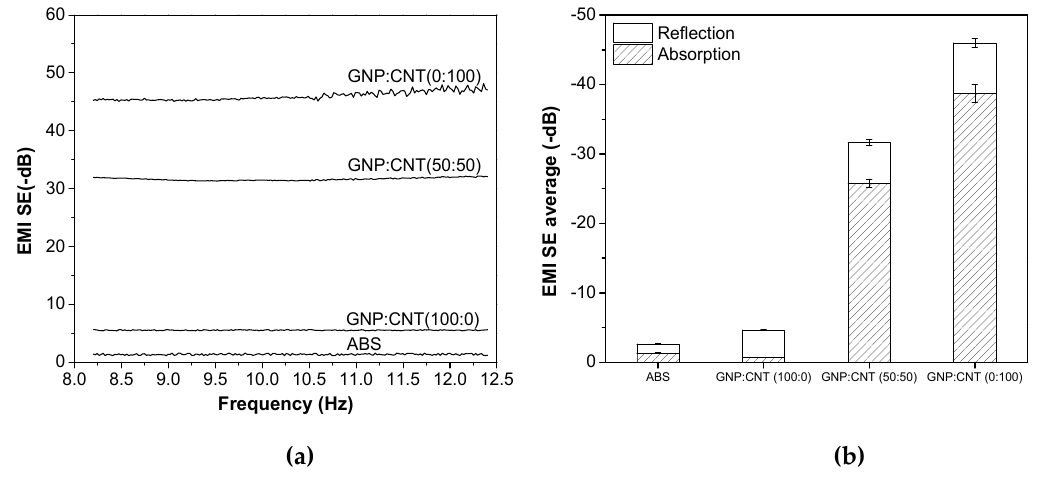
Figure 8. Electromagnetic interference shielding effectiveness (EMI SE0 of neat ABS, as well as single and hybrid nanocomposites, produced by compression molding with a total filler content of 6 wt.%: ( a ) representative curves and ( b ) influence of absorption SE A and reflection SE R mechanisms.